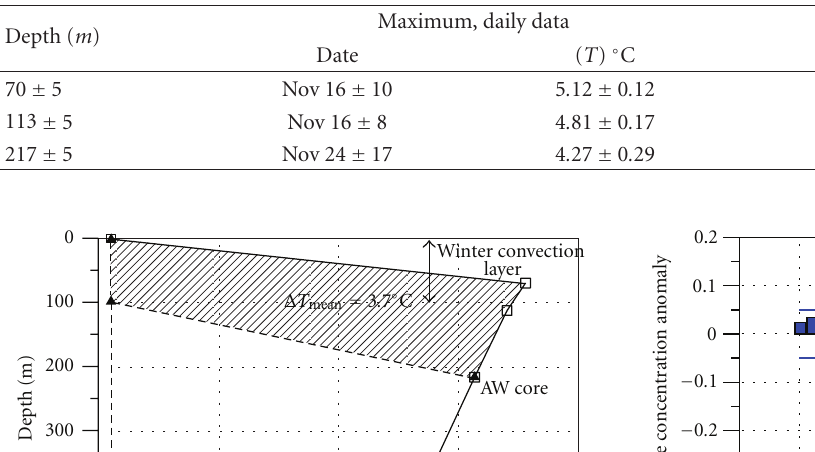
Table 1: Amplitude and phase of seasonal cycle in water temperature at 80 ◦ 30 (cid:3) N and 31 ◦ E [15].